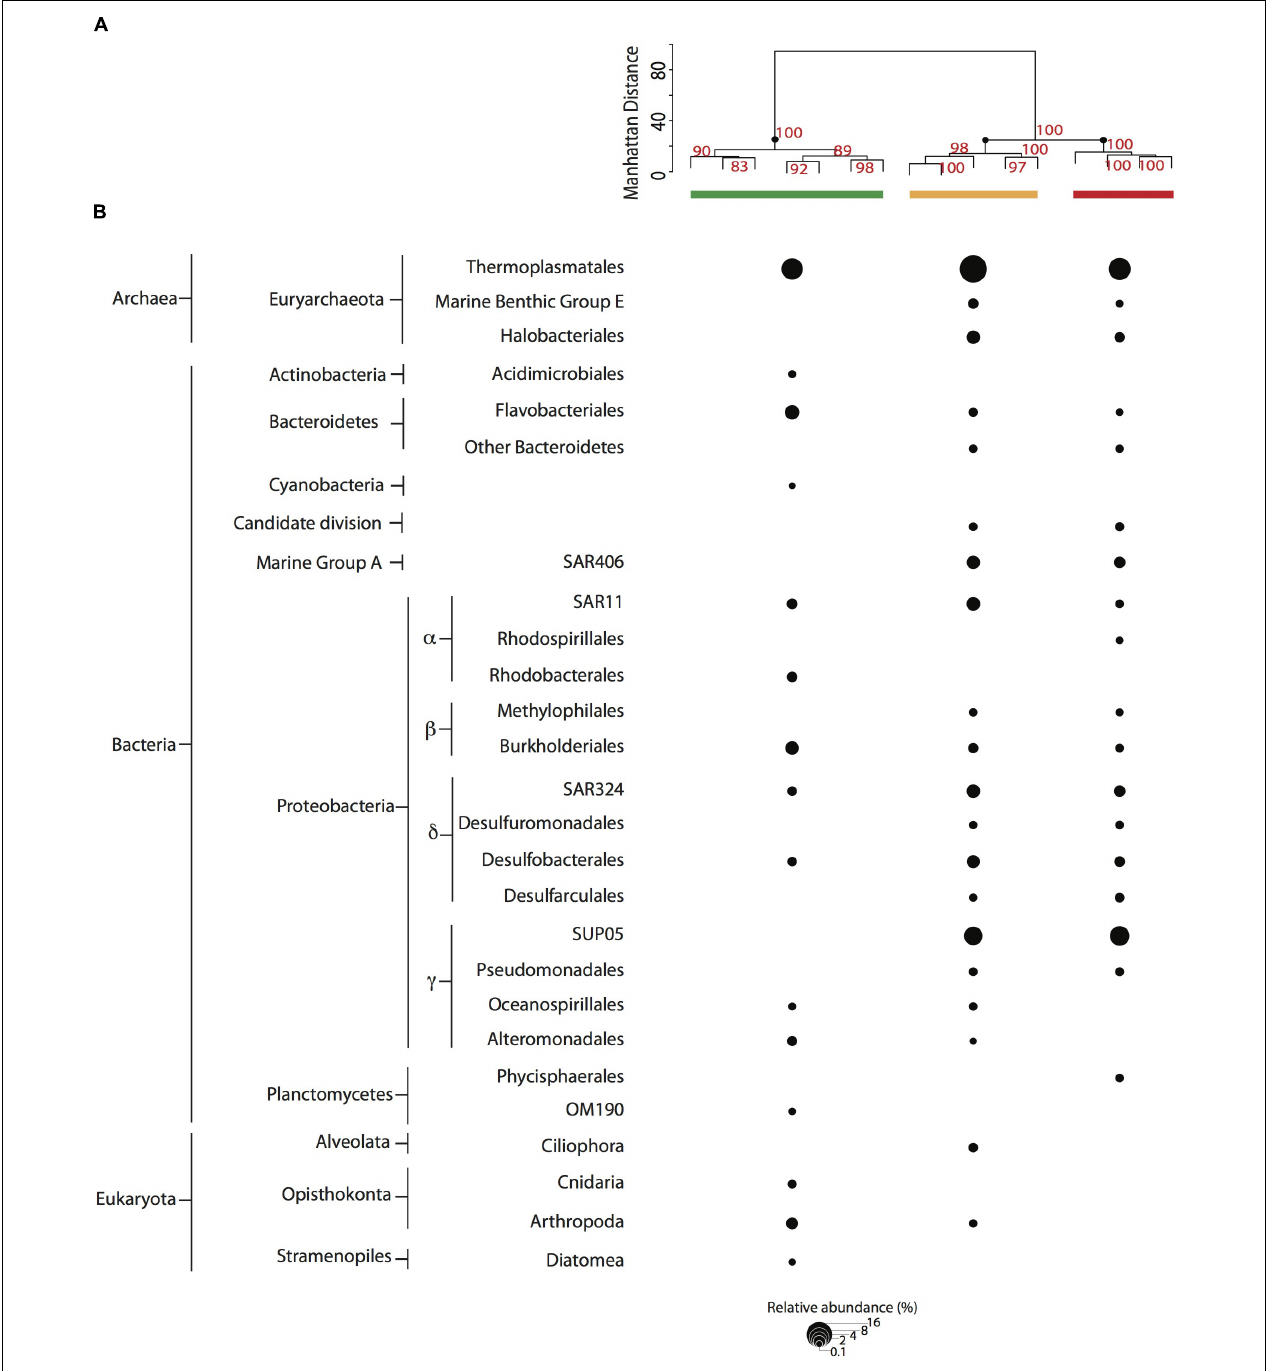
FIGURE 3 | (A) Cluster analysis (AU > 70, 1000 iterations) for 0.4 µ m filter fractions. Samples are depicted with a colored bar by filter type [PPS in situ 0.4 µ m (red), and MPP on-ship 0.4 µ m (green), and 0.22 µ m with in-line 0.4 µ m prefilters (yellow)]. (B) Abundant taxa ( > 0.1% relative abundance from total reads in sample) observed among filter combinations for PPS in situ 0.4 µ m (red), and MPP on-ship 0.4 µ m (green) and 0.22 µ m with in-line 0.4 µ m prefilters (yellow). The size of dots depicts the relative abundance for each taxa as indicated in key.